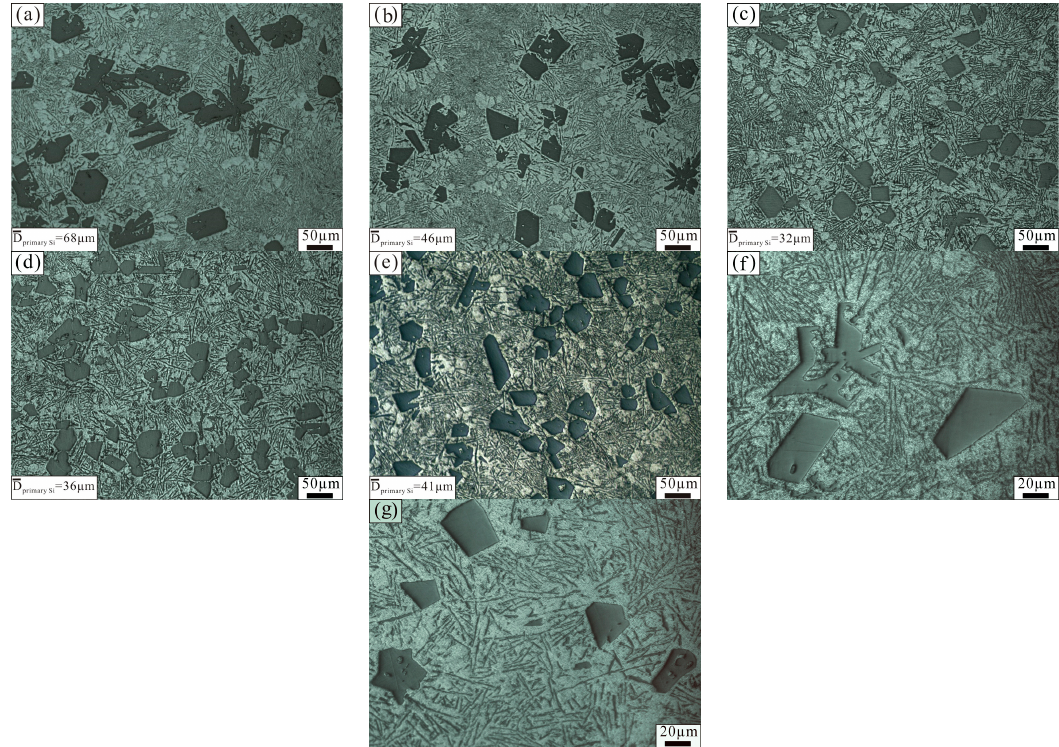
Figure 1. Microstructure of an Al–18Si alloy modified with different amounts of Al–3B: ( a ) 0 wt %; ( b ) 0.1 wt %; ( c ) 0.2 wt %; ( d ) 0.4 wt %; and ( e ) 0.6 wt %; ( f ) Higher magnification of ( a ); ( g ) Higher magnification of ( c ).